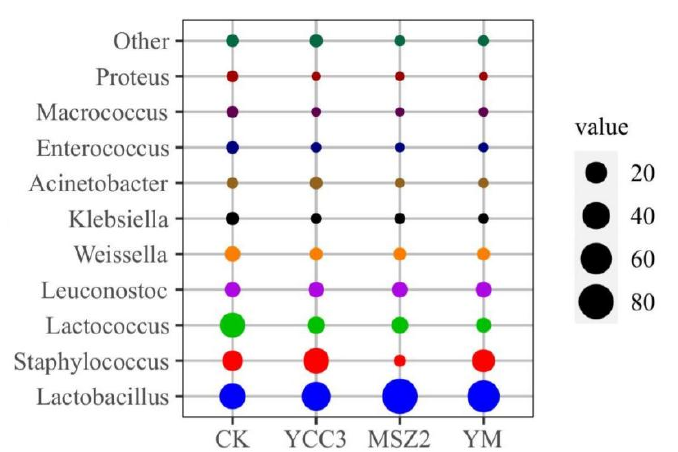
Figure 2. Bubble plot of bacterial relative abundance at genus level of fermented sausage. Different colors indicate different bacteria, the size of the circle indicates the bacteria’s relative abundance.